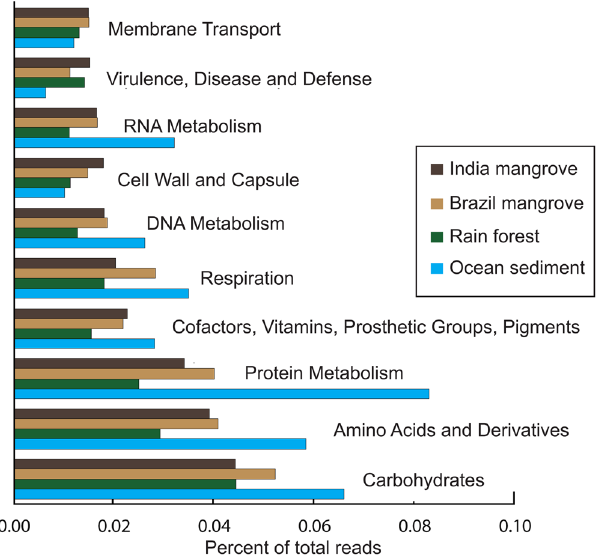
Figure 7. Subsystem functional analysis of representatives from each of the ecosystems analyzed showing the top ten subsystems that the reads were assigned to. Reads that map to genes assigned to specific subsystems are demonstrated for a single representative from each geographic location